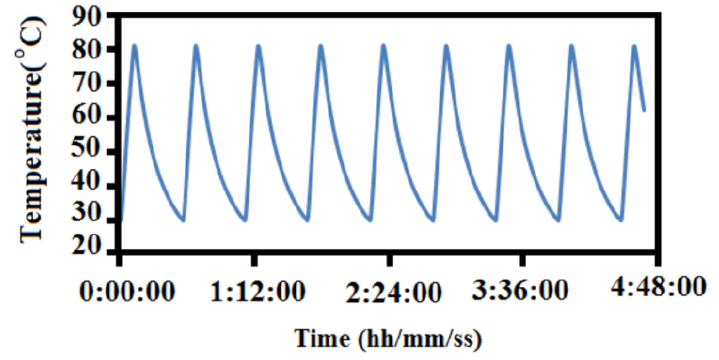
Figure 3. Thermal cycling operation of hot plate heating and cooling temperature with